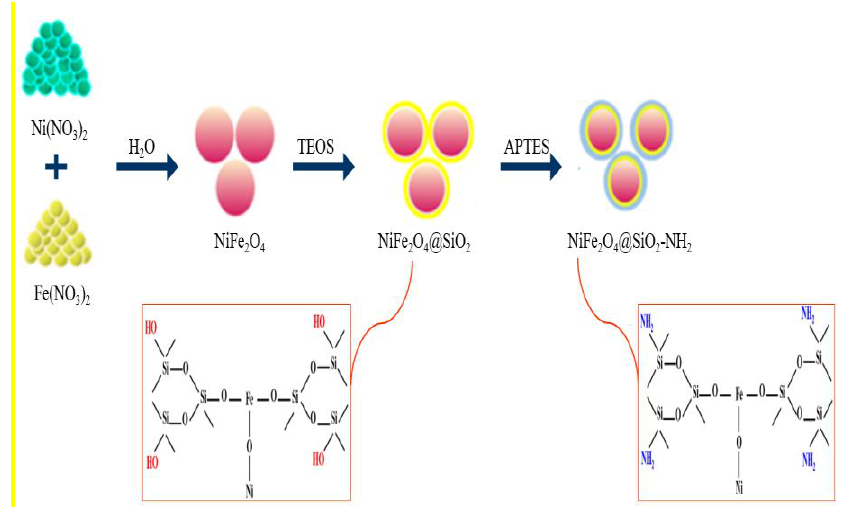
Fig. 1. Schematic of synthesis of nickel ferrite on silica substrate NiFe Fig 1: Schematic of Synthesis of nickel ferrite on silica substrate NiFe 2 O 4 @SiO 2